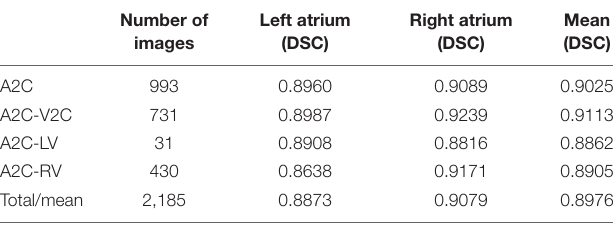
TABLE 4 | Performance results of cardiac anatomy segmentation.